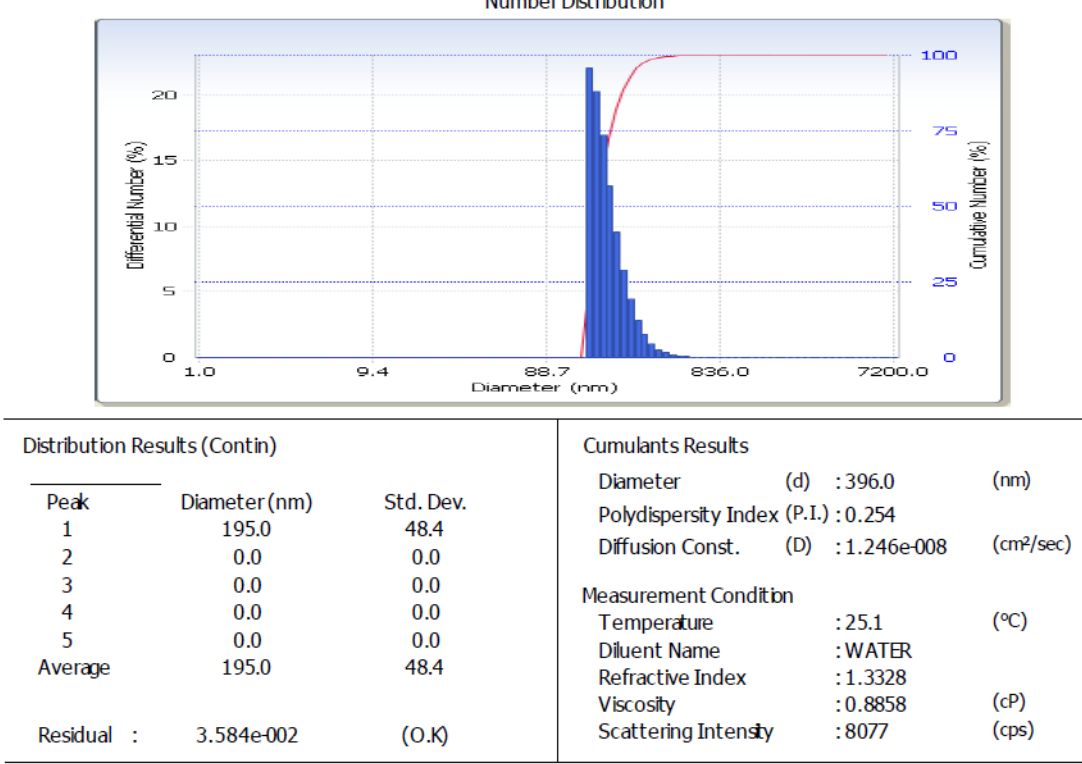
Figure 1. Particle size analysis graphics of arabica coffee ground nanoparticles.